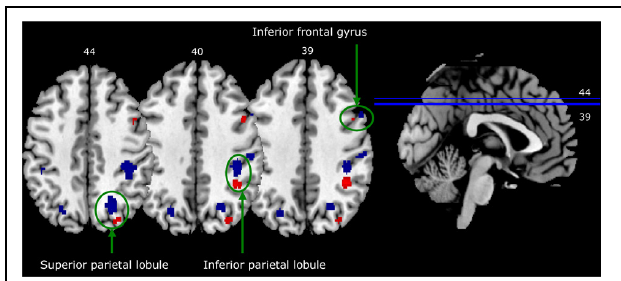
FIGURE 5 | Activation in closely adjacent areas in self—familiar contrast (blue) and in-group—out-groupX identification contrast (red). Both contrasts are thresholded at p < 0 . 0005, with a contiguity threshold of 20 voxels. Images are in neurological format (right = right).